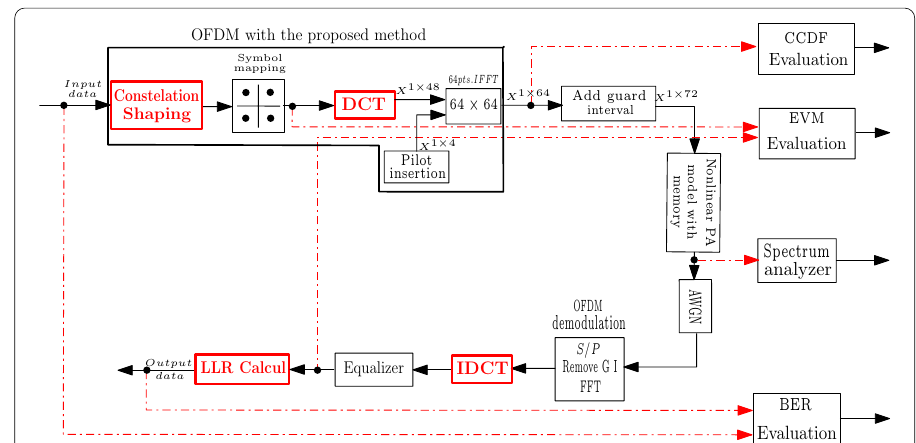
Fig. 9 Simulation block with the proposed method (WLAN 802.11y standard)